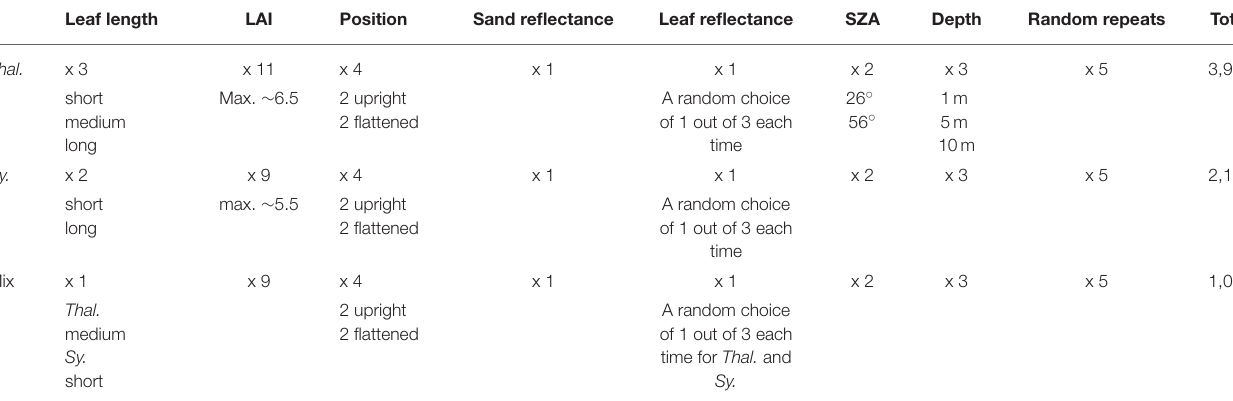
TABLE 1 | Experimental design of model runs for establishing the variation of above canopy diffuse reflectance with LAI and other factors. Leaf length LAI Position Sand reflectance Leaf reflectance SZA Depth Random repeats Total